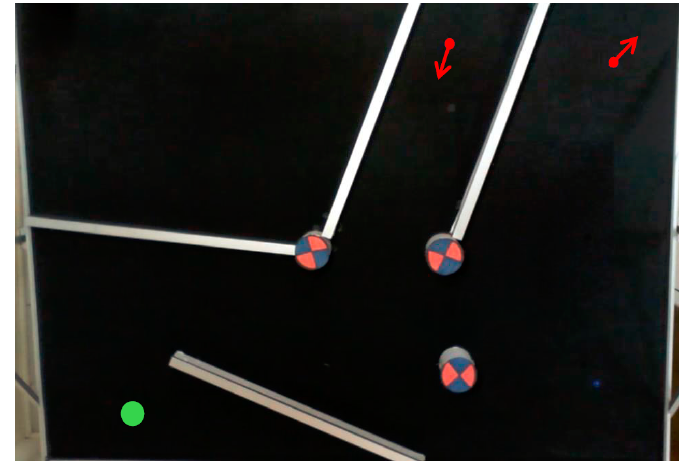
Figure 17. Scenario for obstacle avoidance